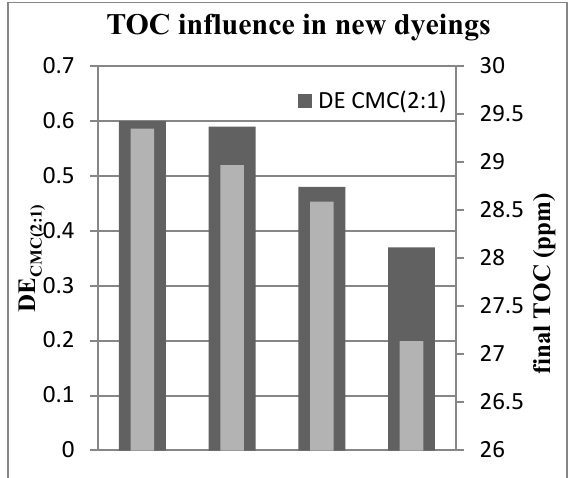
Figure 4. Influence of TOC removal in the reuse of treated effluent for PN: color differences (DE CMC (2:1) ) of dyeings performed with different TOC content effluents.